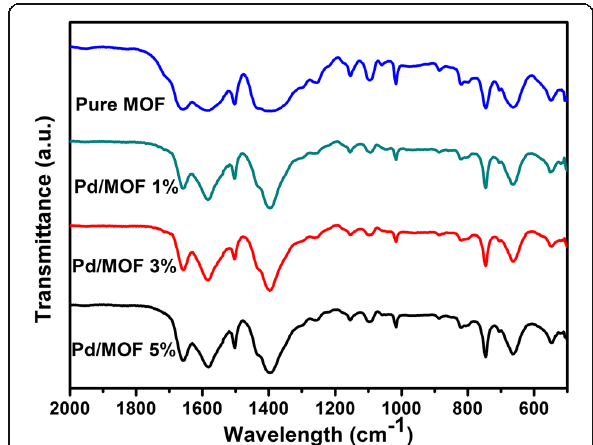
Fig. 4 The Fourier transform infrared spectra (FTIR) of pure UiO-66, Pd/MOF 1%, Pd/MOF 3%, and Pd/MOF 5%